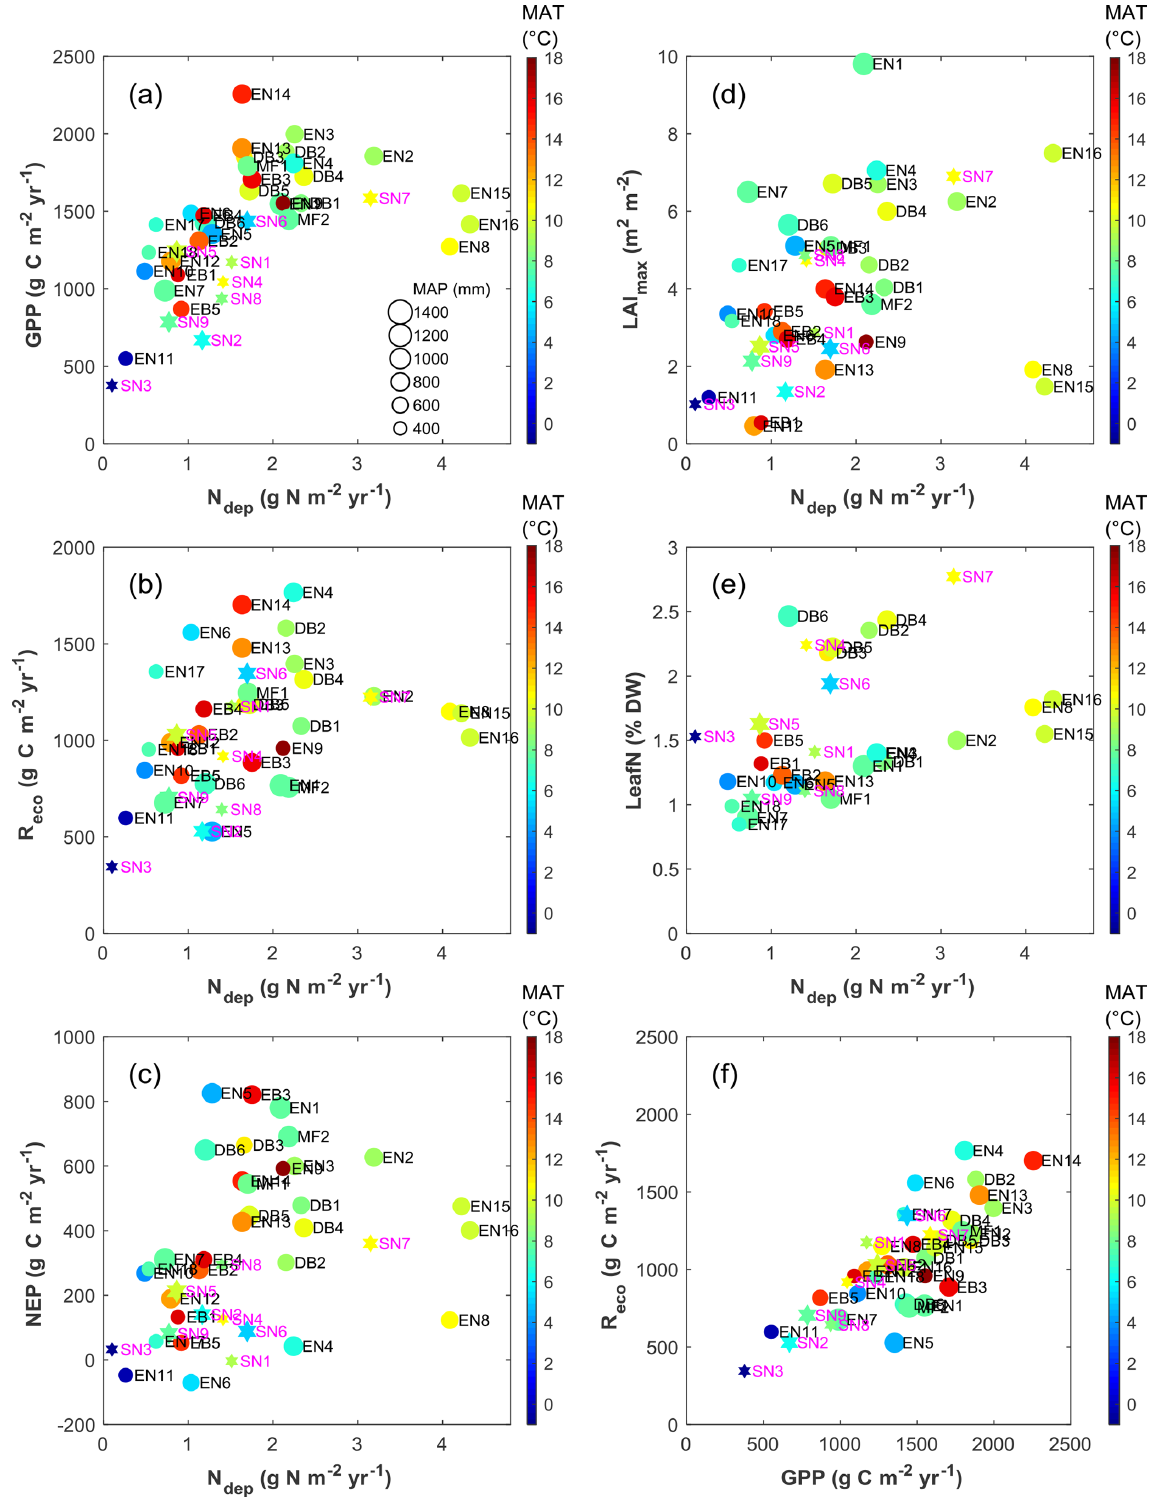
Figure 4. Overview of inter-annual mean EC-derived C flux estimates (GPP, R eco and NEP), ecosystem LAI and leaf N content, in relation to total (dry + wet) atmospheric N r deposition (a–e) , and relationship of R eco to GPP (f) , for forests (filled circles, black labels) and short semi-natural vegetation (filled stars, magenta labels). In all plots, the colour scale indicates mean annual temperature (MAT), while the symbol size is proportional to mean annual precipitation (MAP, scale provided in panel a